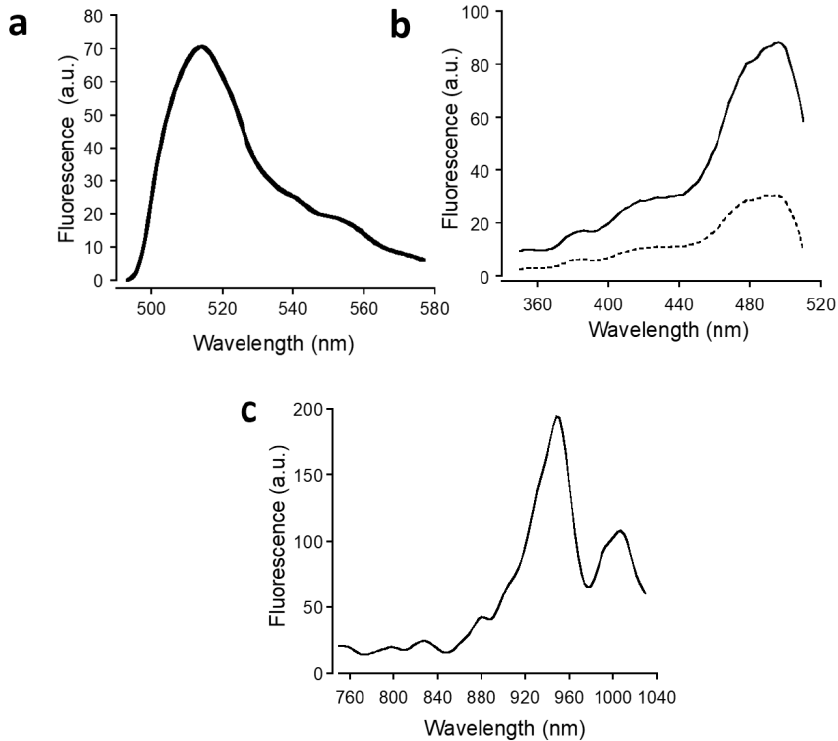
Figure 4. Fluorescence spectral properties. ( a ) In situ fluorescence emission spectrum of LARS1.8 (λ ex = 488 nm) in live HEK293 cells. ( b ) One-photon excitation spectra in the absence (plain line) and in the presence of lactate (10 mM, dotted line). ( c ) Two-photon excitation spectrum.